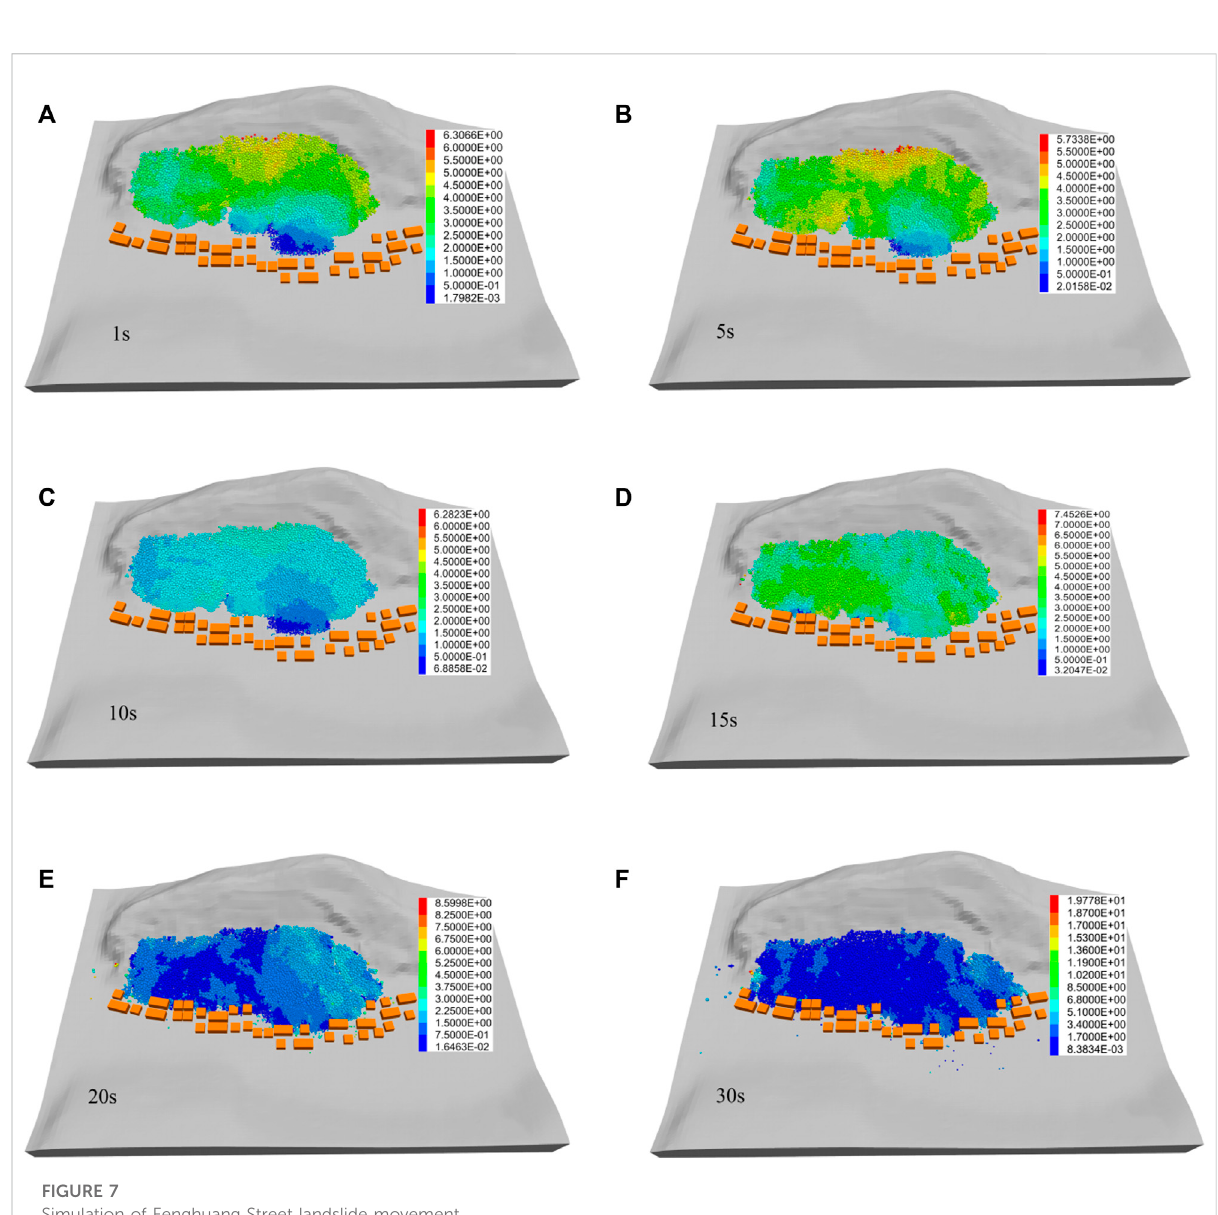
FIGURE 7 Simulation of Fenghuang Street landslide